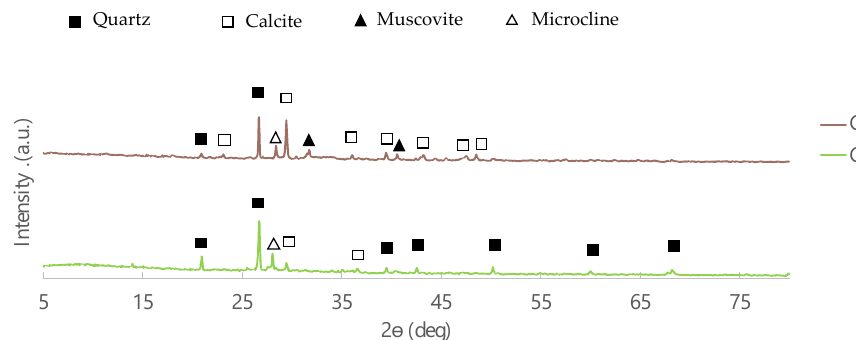
Figure 2. Diffractograms of CA and CT biomass fly ashes.